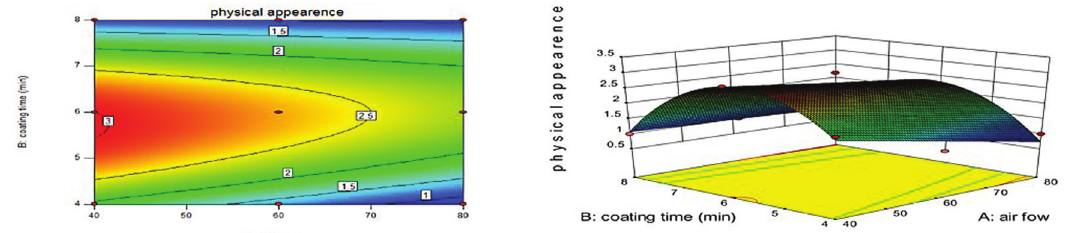
FIGURE 4 - (A) Contour plot (B) Response surface 3D plot; indicating the effect of coating time and airflow rate on physical